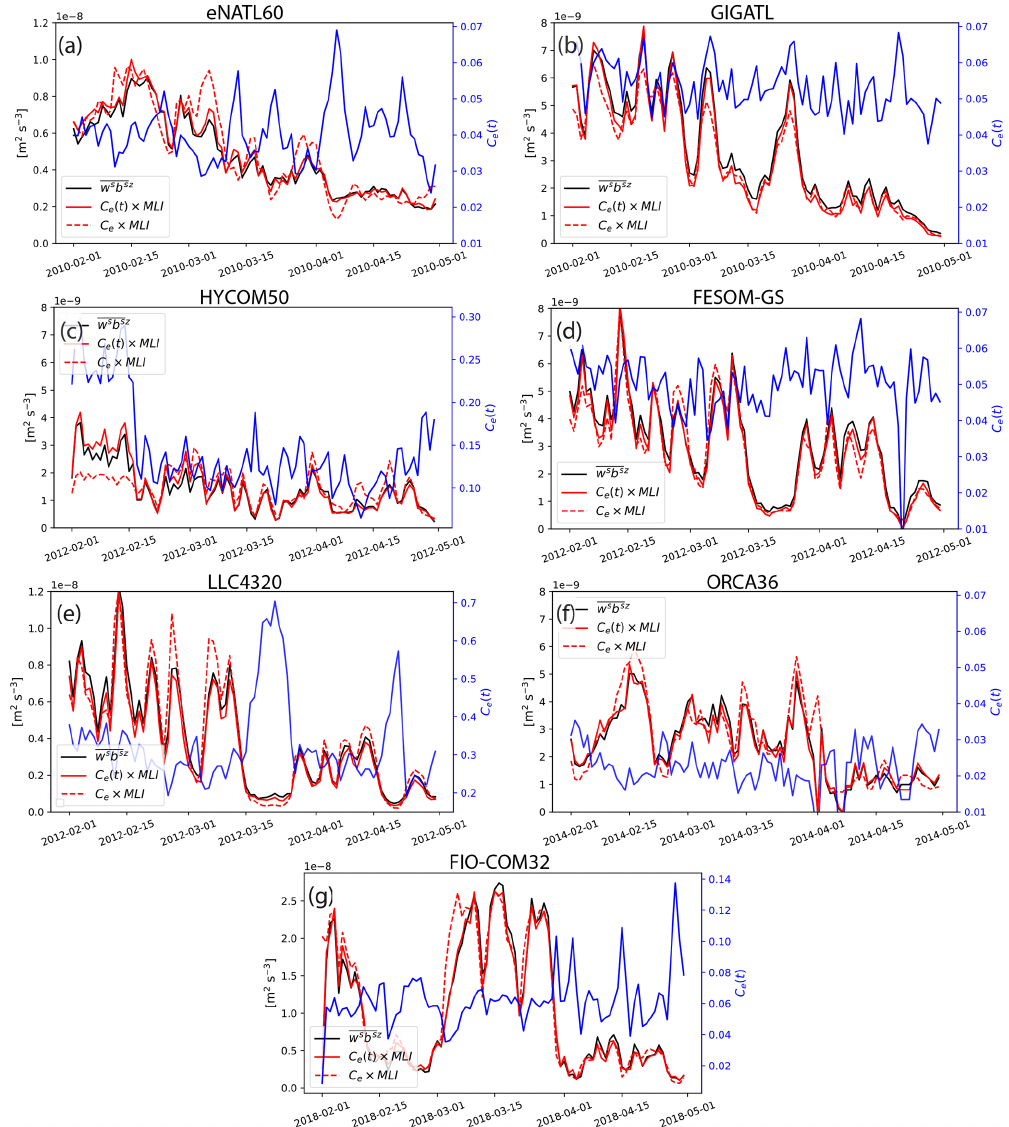
z (cid:105) ; black solid